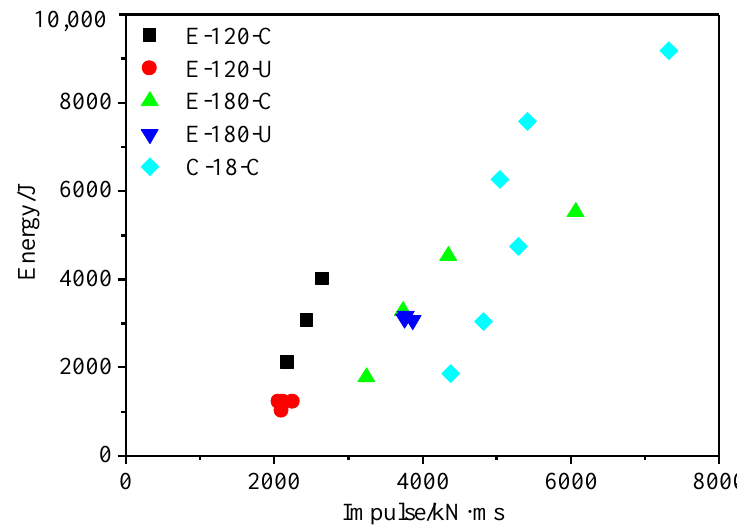
Figure 11. Energy dissipation vs. impulses relationships for all the tested specimens.